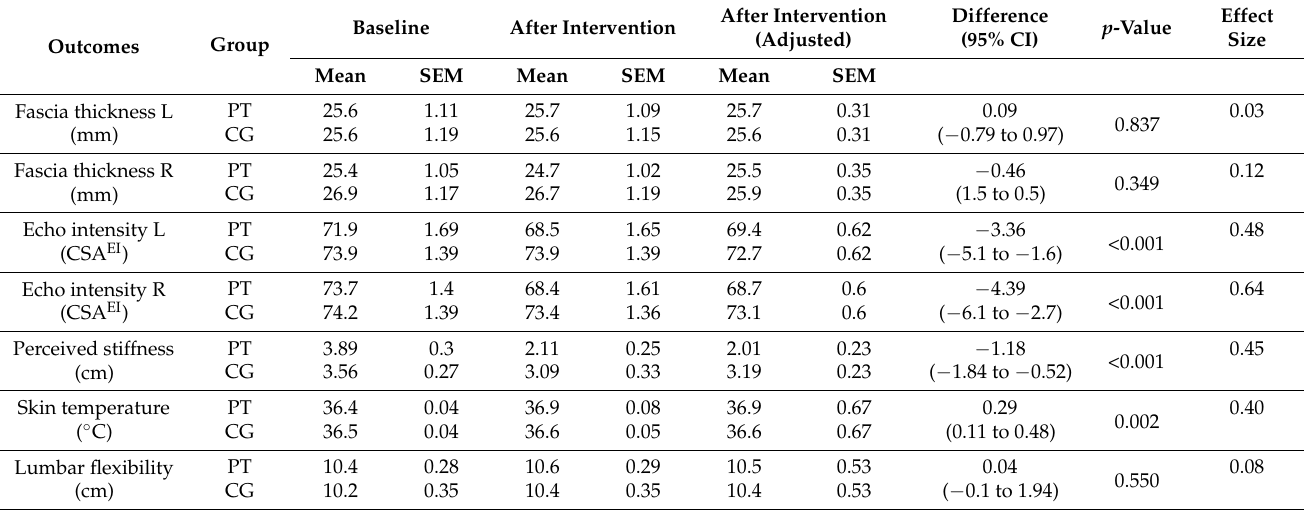
Table 3. Post differences of all the outcomes between groups, baseline adjusted using